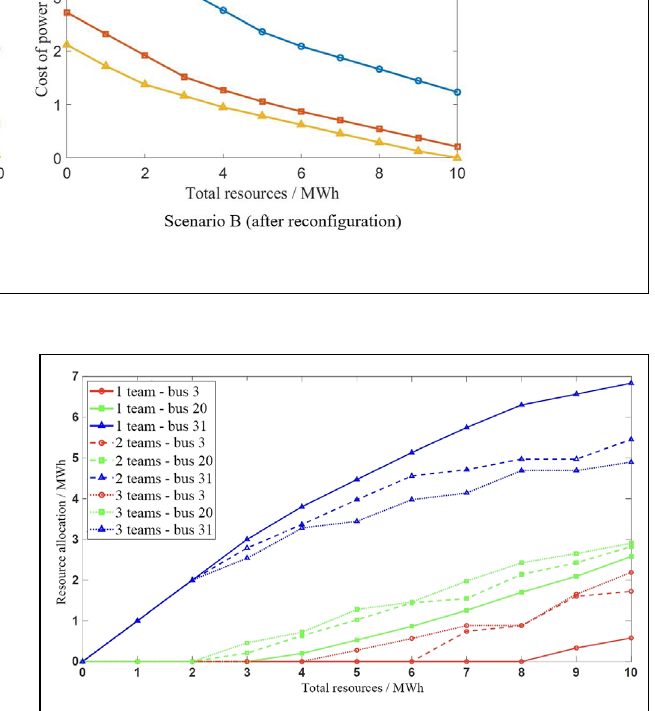
FIGURE 9 | Optimal power supply resource allocation in scenario B. FIGURE 10 | Optimal resource allocation in multiple disaster